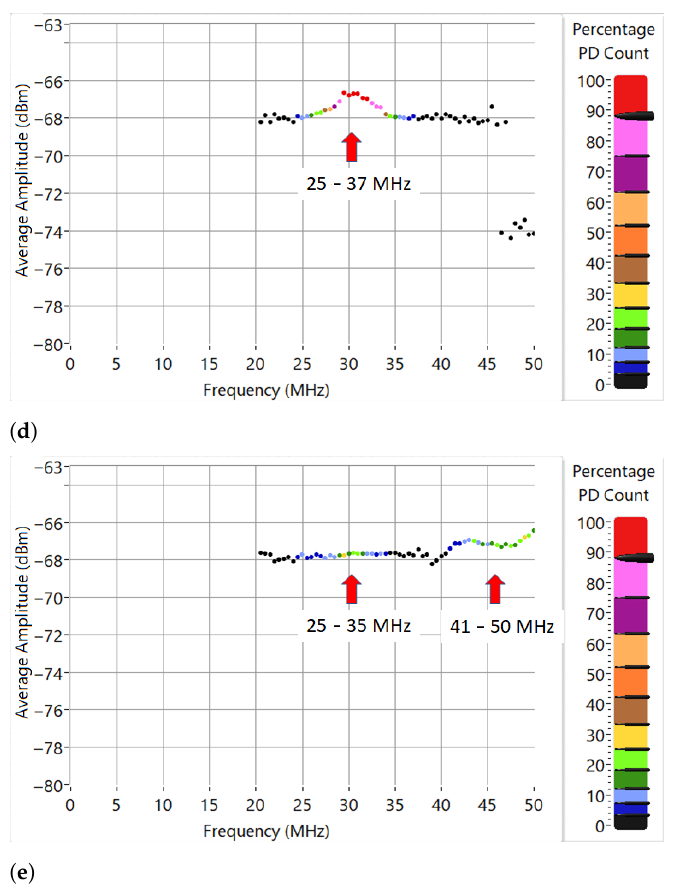
Figure 15. FRPD for different cases, from 0 to 50 MHz: ( a ) corona, ( b ) slot, ( c ) corona with slot, ( d ) noise with the power supply not energized, and ( e ) noise with energized power